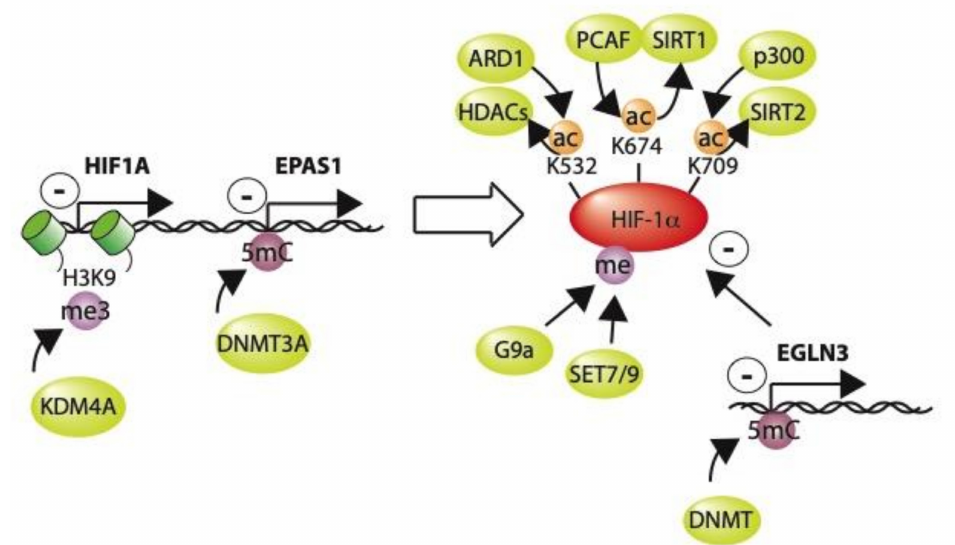
Figure 3. Histone and DNA modifying enzymes that a ff ect HIF levels. Removal of the repressive H3K9me3 mark by KDM4A at the HIF1A locus activates transcription of HIF-1 α . Conversely, CpG methylation at the EPAS locus suppresses transcription of the HIF-2 α isoform. Reversible acetylation of multiple residues on HIF-1 α has variable e ff ects on HIF-1 α stability. Similarly, methylation of the molecule by G9a or SET7 / 9 also a ff ects its stability. Methylation of the EGLN3 promoter suppresses transcription of this negative regulator of